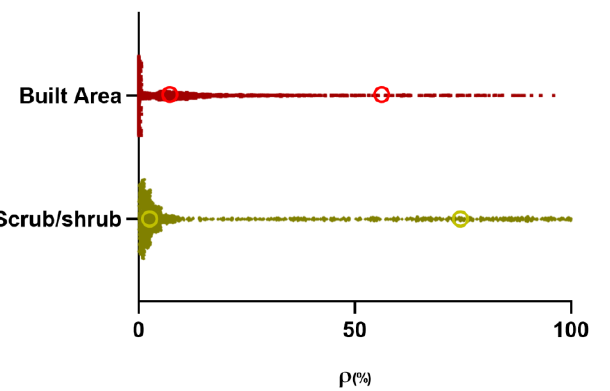
Figure 5. Distribution and clustering centers (marked with cycles) of built-up area ratio and shrub/shrub ratio in the samples. Y -axis represents the Built Area and Scrub/shrub samples of land cover types, and X -axis represents the proportion of corresponding land cover types in the samples. Table 2. Road extraction results obtained by different clustering methods.